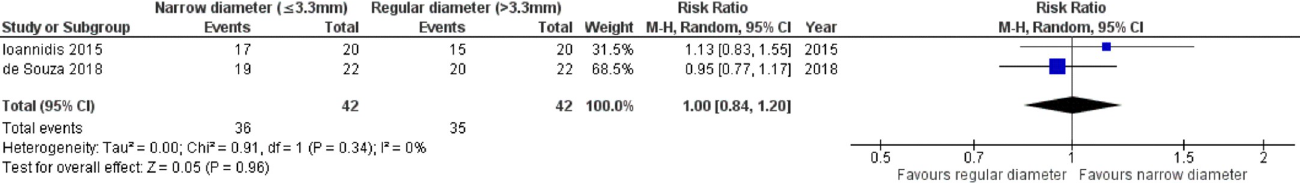
Fig 3. Forest plot of randomized clinical trials comparing the longevity of narrow and standard implants.